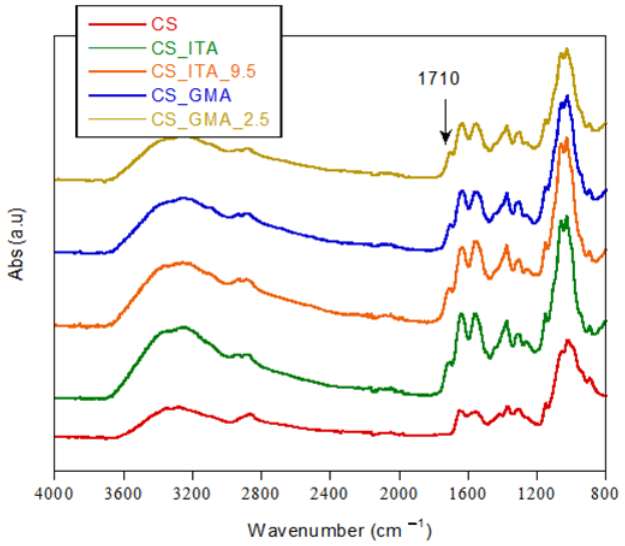
Figure 2. FT-IR spectra of some CS_GMA_X and CS_ITA_X MIPs and NIPs.